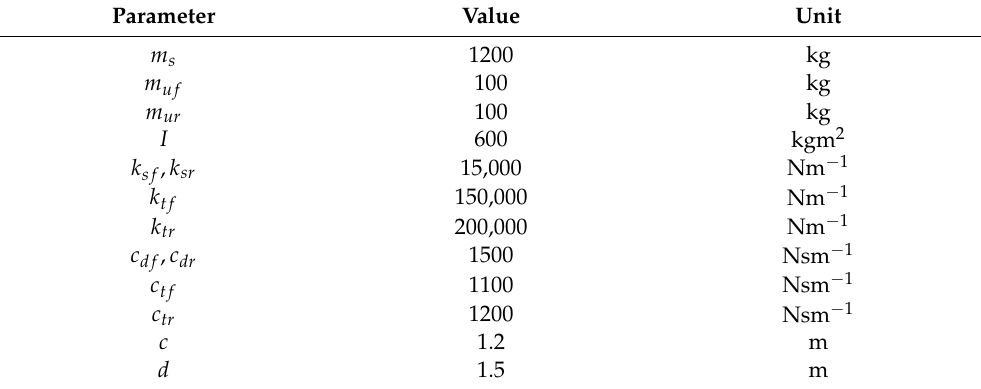
Table 1. Half-car suspension parameters.